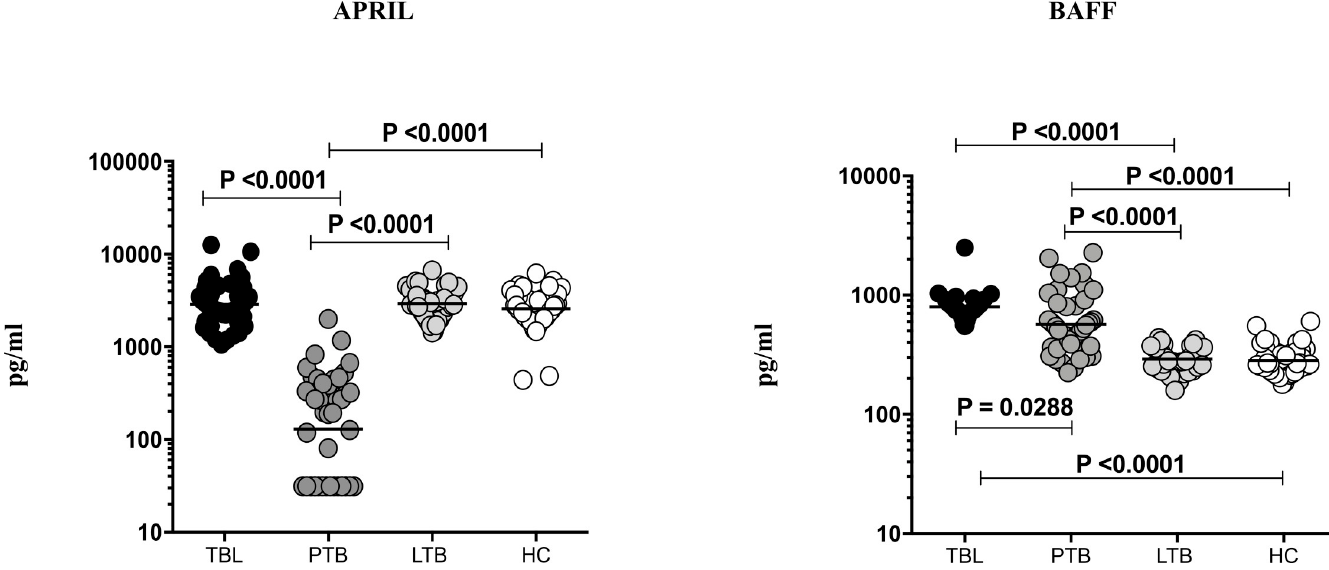
Fig 1. PTB and/or TBL are associated with diminished APRIL and elevated BAFF levels. The systemic levels of BAFF and APRIL were measured in active PTB (n = 44), TBL (n = 44), LTB (n = 44) and in HC (n = 44). The results are shown as scatter plots with each circle representing a single individual and the bar representing the geometric mean. P values were calculated using the Kruskal-Wallis test with Dunn’s multiple